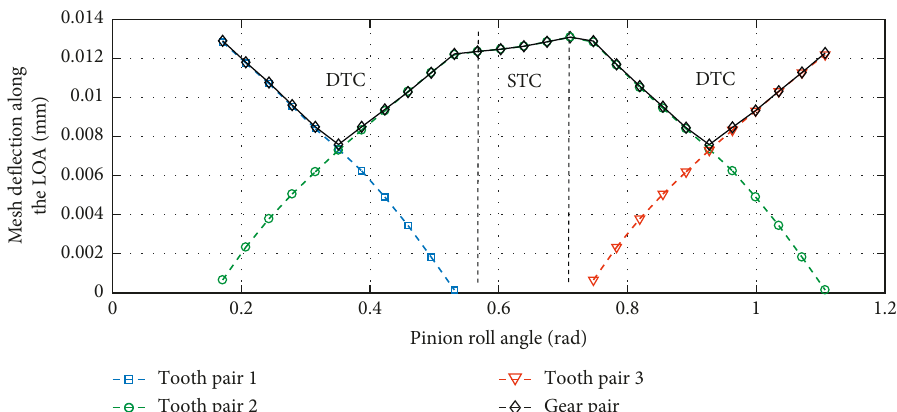
Figure 11: Mesh deflection along the line of action of the gear pair and the tooth pair over one tooth engagement cycle at 300Nm applied torque.